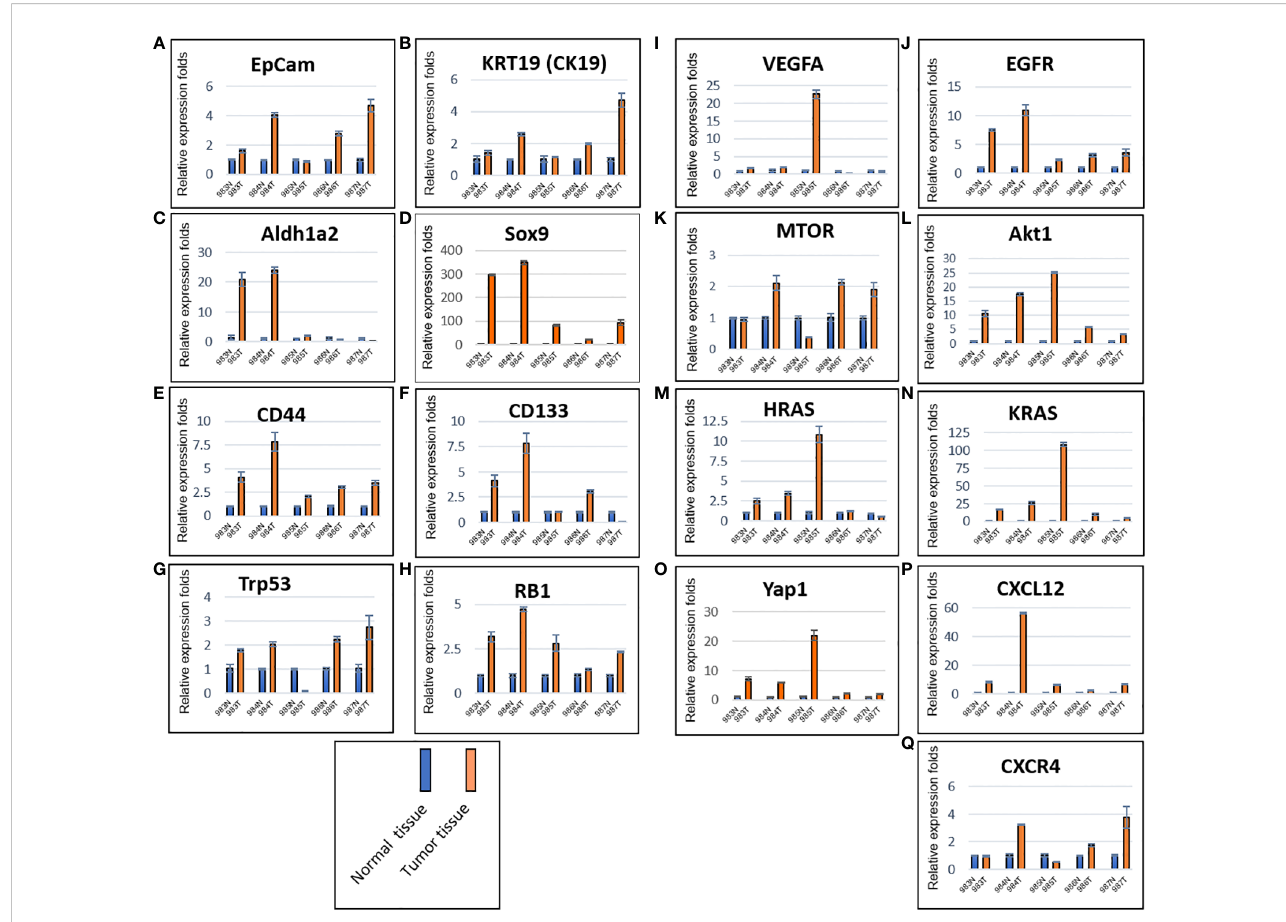
FIGURE 5 Murine P0825-cells-generated P0825-PDX tumors in SCID mice expressed higher in mRNAs of cancer related markers compared to adjacent normal tissues. Cancer markers EpCam and CK19 (A, B) ; cancer stem cell markers Aldh1a2, Sox9, CD44, and CD133 (C – F) ; tumor suppressor markers TP53 and RB (G, H) ; growth factors VEGFa and EGFR (I, J) ; oncogenic driver genes mTOR, Akt1, HRas, KRas and Yap1 (K – O) ; cytokine and chemokine markers CXCL12 and CXCR4 (P, Q)